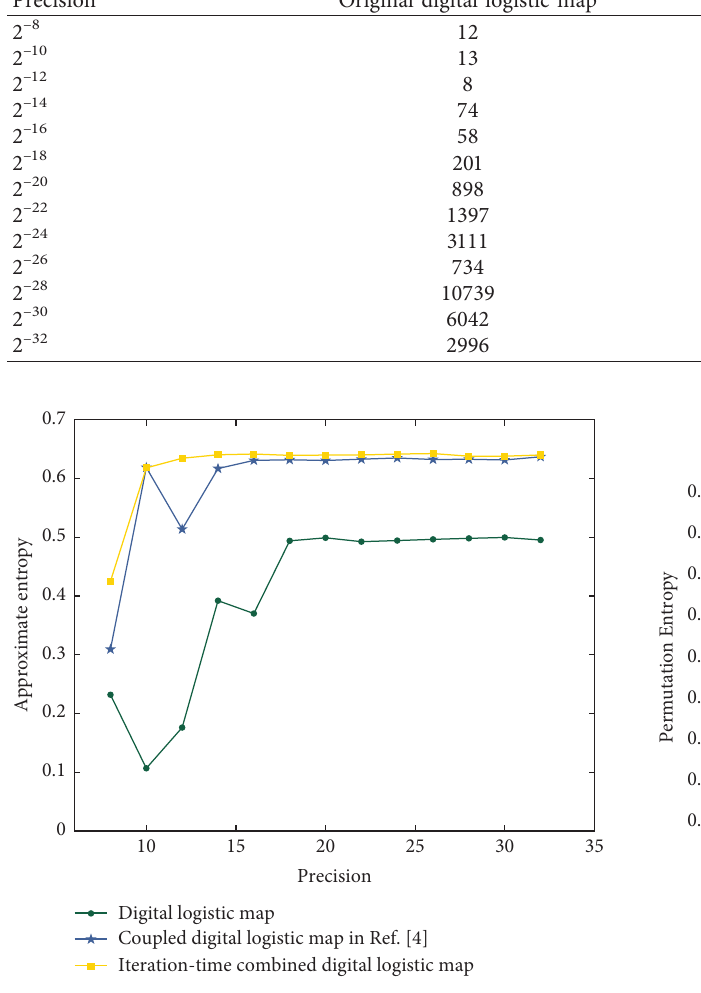
Figure 5: The PE of the digital logistic map and iteration-time combined digital logistic